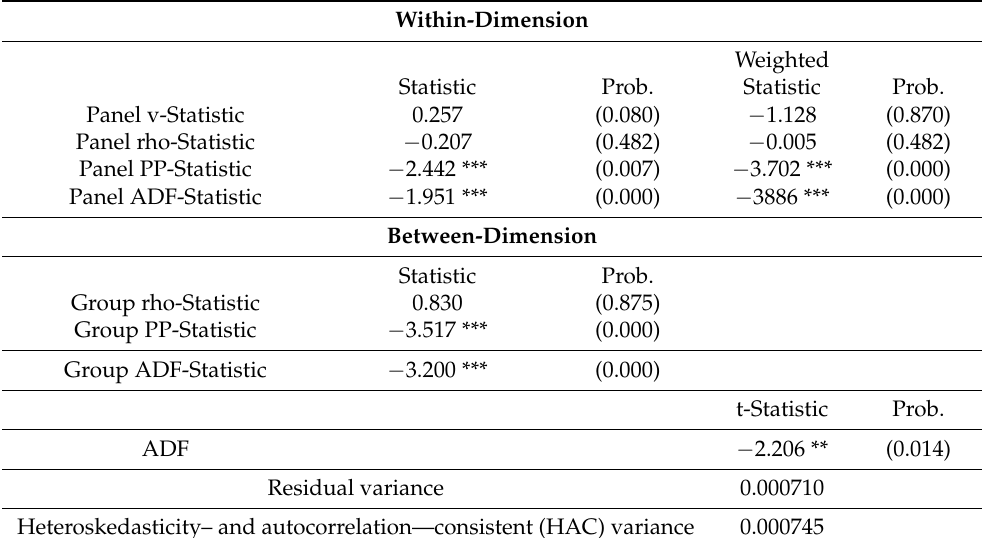
Table 4. Panel Cointegration test of Pedroni and Kao residual